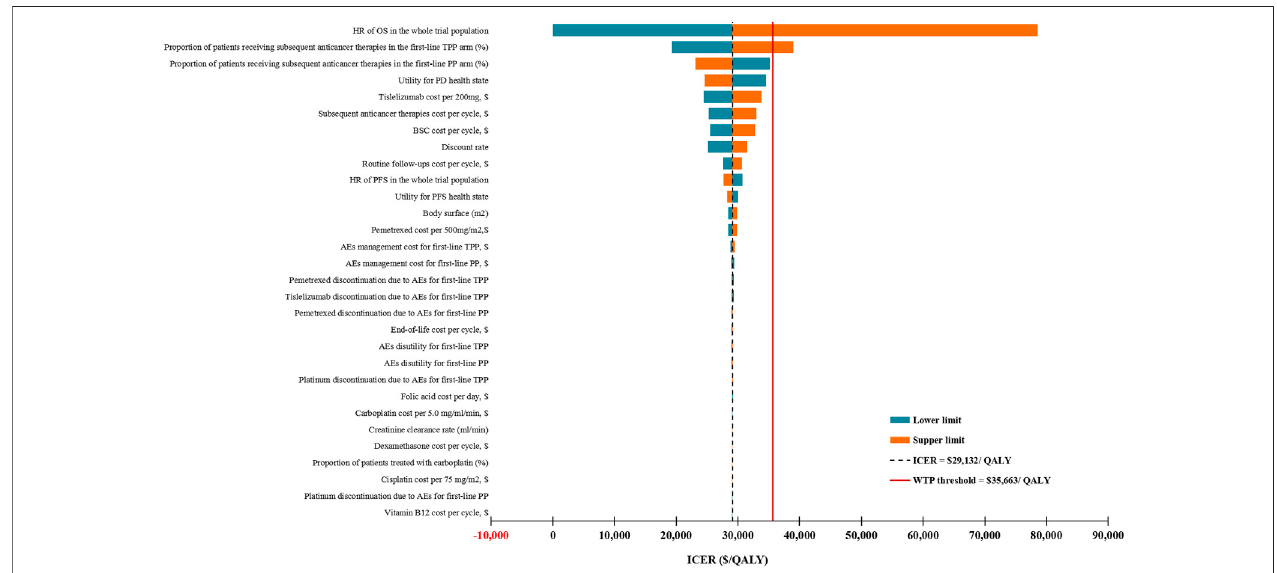
FIGURE2| Deterministic sensitivity analysisresultsfortheentirepatientpopulation.ICER, incremental cost-effectivenessratios; QALY,quality-adjusted life-years; WTP, willingness-to-pay; TPP, tislelizumab plus pemetrexed-platinum chemotherapy; PP, pemetrexed-platinum chemotherapy; HR, hazard ratio; OS, overall survival; PFS, progression-free survival; PD, progressive disease; AEs, adverse events; BSC, best supportive care; PD, progressive disease.